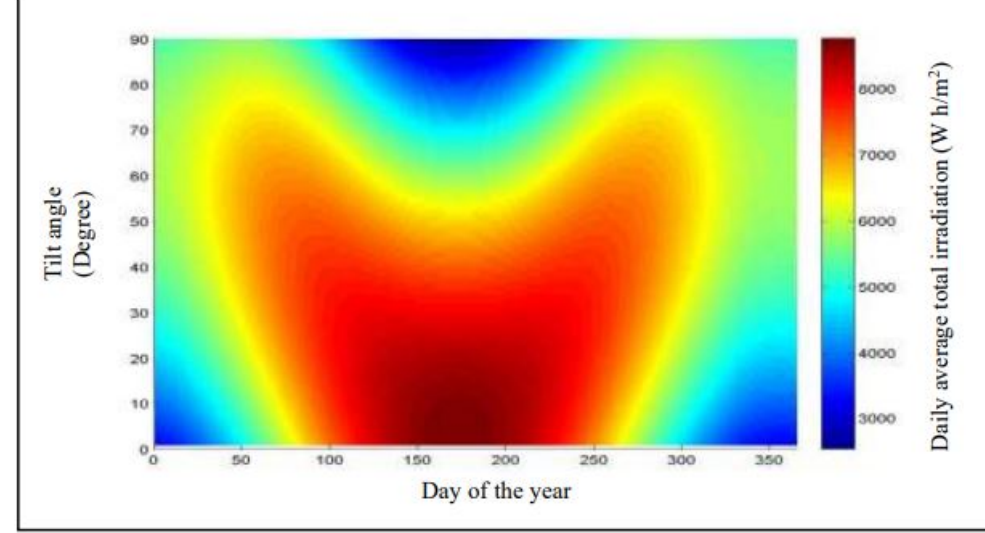
Figure 9. The daily average whole irradiation (W.h/m 2 ) intercepted via the surfaces having various angles of tilt